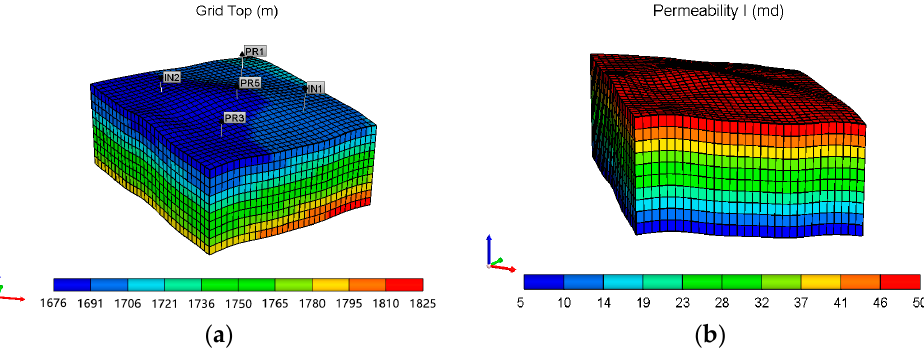
Figure 7. Three-dimensional model. ( a ) Grid setting and well location; ( b ) Permeability distribution.